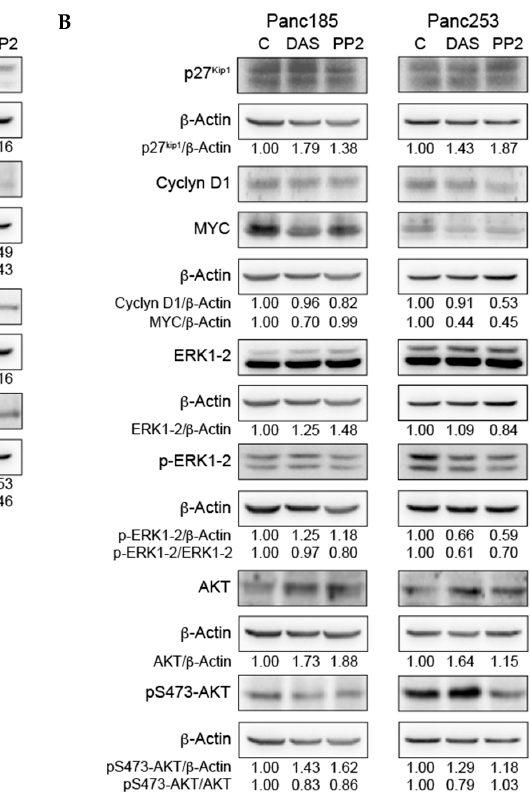
Figure 1. The effect of inhibition of SRC kinases on key signaling factors. ( A ) WB analysis of SRC kinases and pY419– SRC protein expression (top) or FAK and pY925–FAK (bottom) in control-, dasatinib (DAS)- or PP2-treated Panc185 or Panc253 PaCSCs. The indicated ratios for pY419– SRC/SRC kinases and pY925–FAK/FAK were determined, and the fold-changes are shown, setting diluent (C)-treated cells as 1.0. ( B ) WB analysis of p27 Kip1 , cyclin D1, MYC, ERK1-2, pERK1-2, AKT, or pS473–AKT protein levels in control-, DAS-, or PP2-treated Panc185 or Panc253 PaCSCs. The indicated ratios for p27 Kip1 / β -actin, cyclin D1/ β -actin, MYC/ β -actin, pERK1-2/ERK1-2, and pS473–AKT/AKT were determined and the fold-changes are shown, setting diluent (C)-treated cells as 1.0. Densitometric analysis of the indicated bands was determined using ImageJ software, and all values were normalized to β -actin values, which were included as a loading and normalization control. Four gels were run and transferred. Gel/membrane 1 was blotted for pY419– SRC , pY925–FAK, total ERK1-2, MYC and Cyclin D1 and thus share the same β -actin control. Gel/membrane 2 was blotted for SRC kinases, FAK and pERK1-2 and thus share the same β -actin control. Gel/membrane 3 was blotted for total AKT and β -actin. Gel/membrane 4 was blotted for pS473–AKT and p27 and thus share the same β -actin control. Uncropped and unprocessed images of Gels 1–4 can be found in Figure S4. This error does not affect any of the data or conclusions in the article, and all densitometric analyses remain the same. The authors apologize for any confusion this error may have caused to the readers.